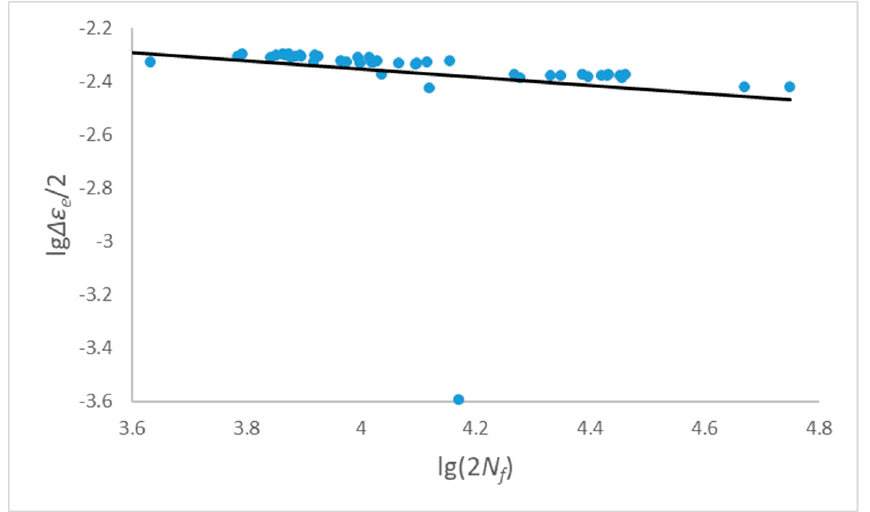
Figure 1. Fitting of elastic parameters when R = 0.05.